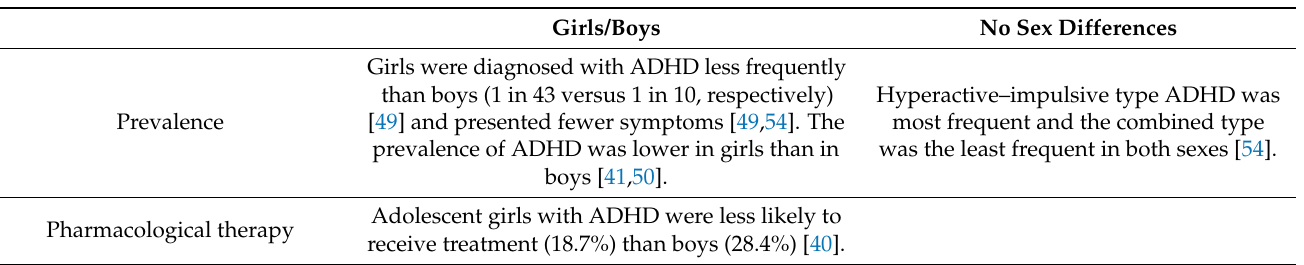
Table 3. Sex differences in the prevalence of attention-deficit hyperactivity disorder and pharmaco- logical therapy.